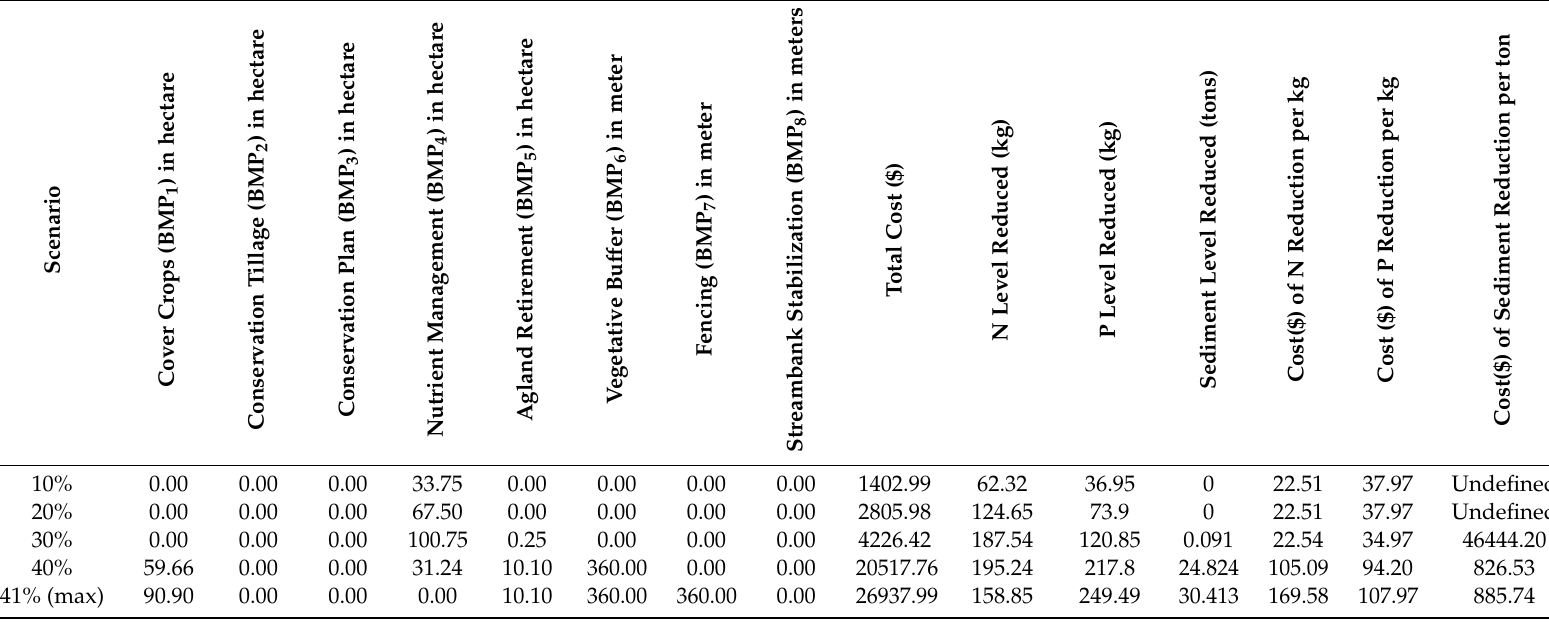
Table 6. Summary of BMP adopted area, total cost of pollutant reduction, and unit cost of nitrogen, phosphorus, and sediment reductions under alternative weather scenarios in the Saline Bayou watershed (Dry Year